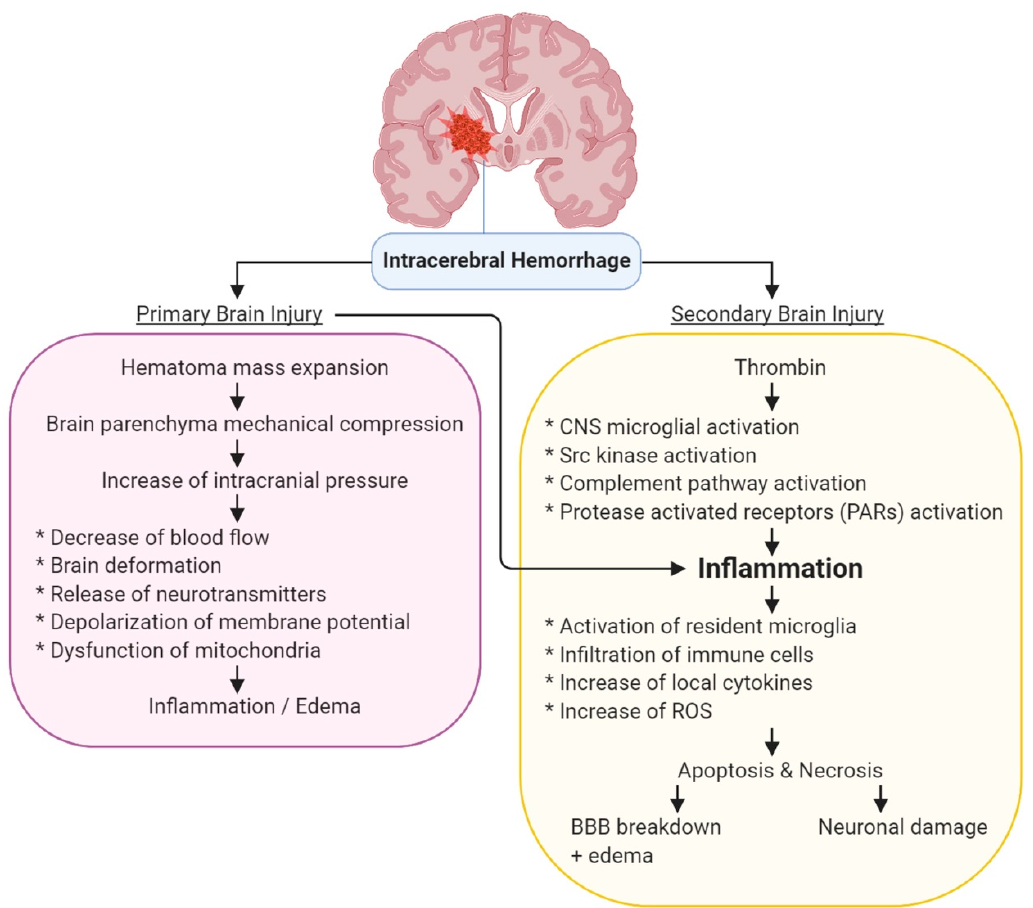
Figure 1. Primary and secondary injuries caused by intracranial hemorrhage. Abbreviations: ROS, reactive oxygen species; BBB, blood-brain barrier.